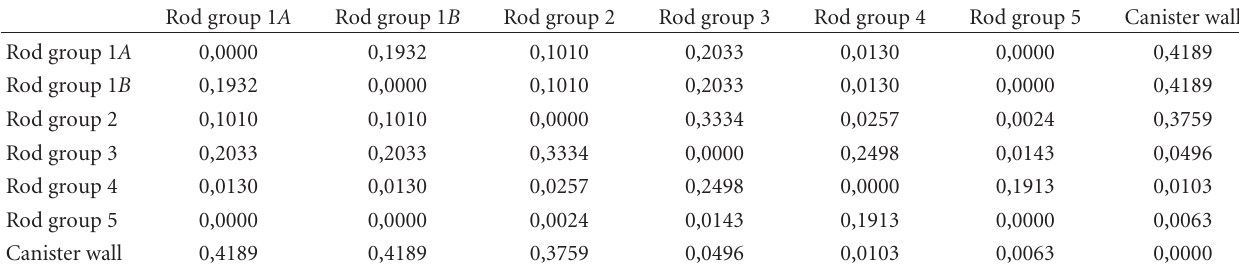
Table 3: View factors used in